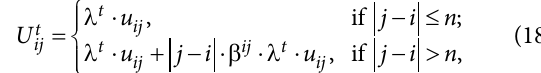
optimal frequency of short-turn line Figure 6. Frequencies of optimal lines with three transfer fare discount scenarios: a – 0% discount for transfer; b – 50% discount for transfer; c – 100% discount for transfer